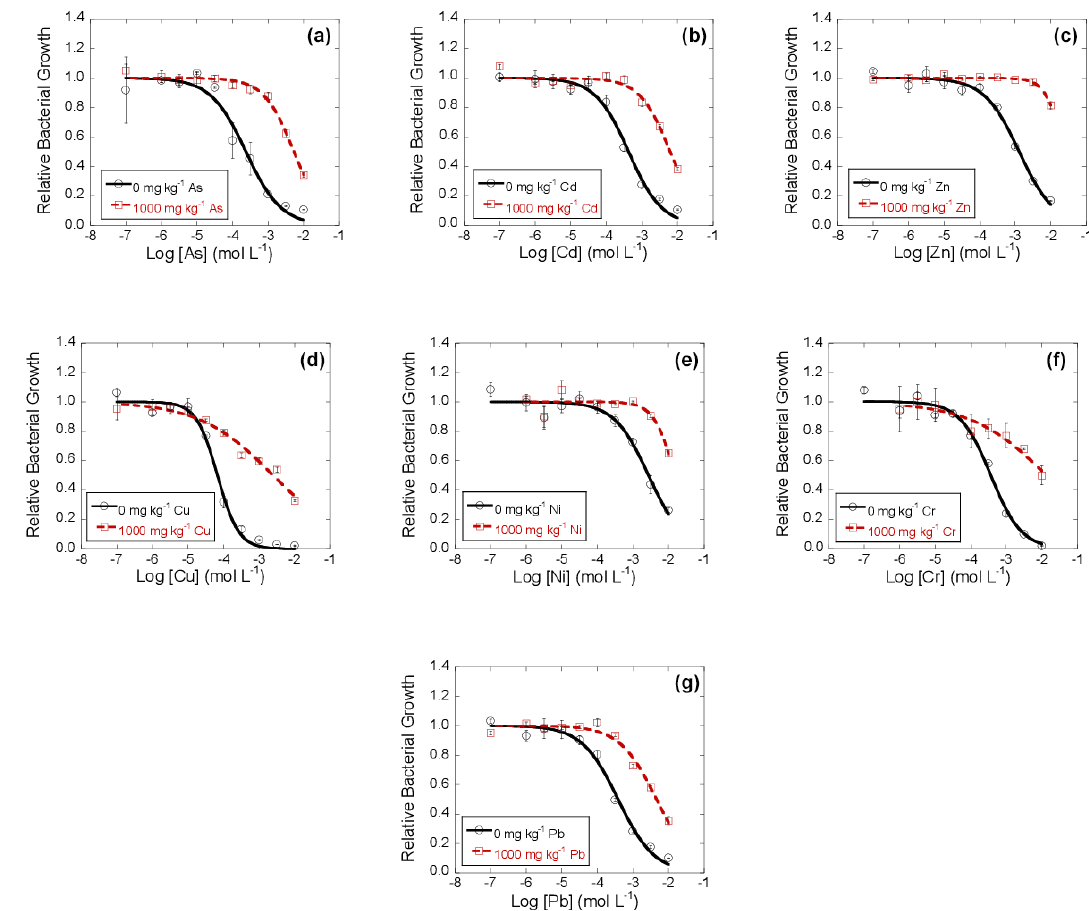
Figure 1. Dose–response curves obtained after the addition of 10 different concentrations of the heavy metals As (a) , Cd (b) , Zn (c) , Cu (d) , Ni (e) , Cr (f) , and Pb (g) to bacterial suspensions extracted from soils polluted with 1000mgkg − 1 of each of the same heavy metals, separately, after 42d of incubation. Black lines represent the dose–response curves corresponding to the unpolluted soil (control), and dashed red lines are dose–response curves corresponding to the soil polluted with 1000mgkg − 1 of heavy metal. Average values ( n = 3) with coefficients of variation always <